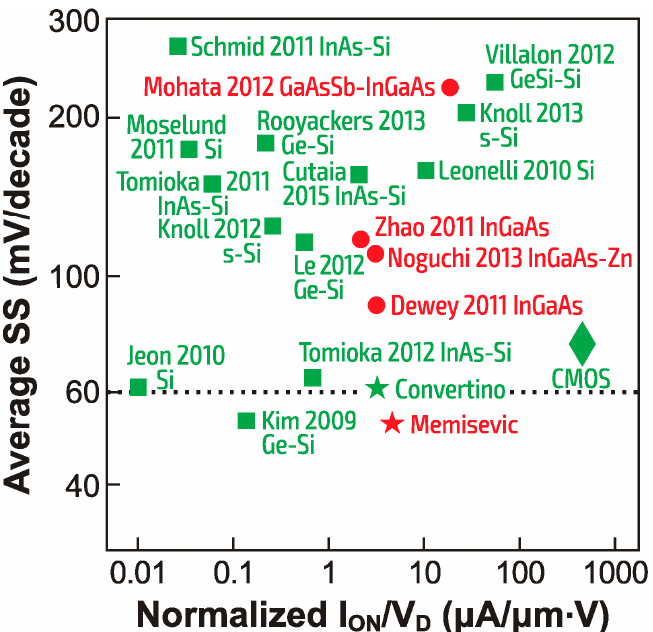
Figure 25. Average subthreshold swing SS vs. normalized I ON plot, using the Cutaia et al. benchmark- ing approach [63]. Reproduced from [7], with additional recent data points from [64,65] indicated with stars. Green points indicate CMOS-compatible